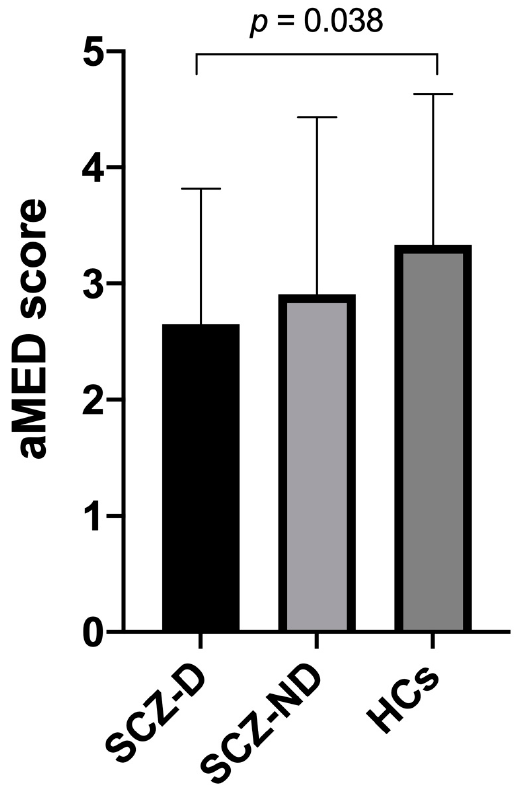
Figure 1. Mean aMED scores in individuals with deficit schizophrenia (SCZ-D), non-deficit schizophrenia (SCZ-ND), and healthy controls (HCs). Error bars represent standard deviations. Bivariate correlations of the aMED score among individuals with schizophrenia and healthy controls are reported in Table 2 and Figure 2. There were significant negative correlations of the aMED score with BMI, the PANSS scores of negative symptoms, and the SNS scores (total score, alogia, avolition, and anhedonia). No significant correlations controls, correlations of the SNS score with the aMED score were not assessed in this group of